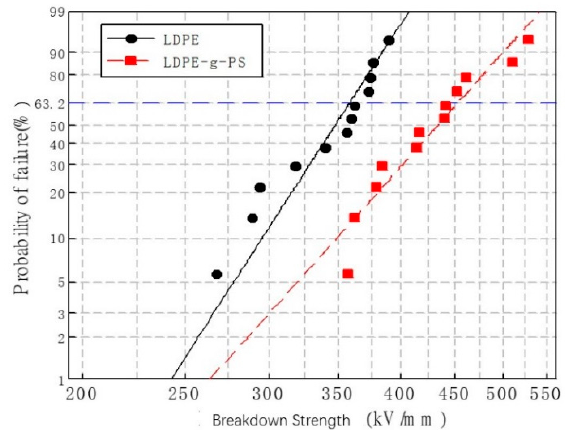
Figure 6. Weibull plots of the direct current (DC) breakdown strength of LDPE and LDPE-g-PS/LDPE blend.